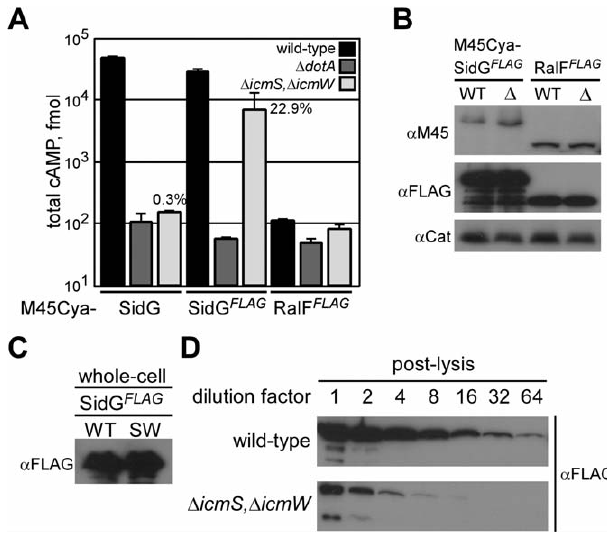
Figure 8. A C-Terminal FLAG Epitope Alters the Requirement for icmSW in SidG Translocation (A) CHO Fc c RII cells were infected with wild-type (black), D dotA (dark grey), or D icmS , D icmW (light grey) strains expressing the indicated Cya hybrid proteins. Total cAMP production induced by translocation of the hybrid was determined as in (Figure 1). % values represent translocation efficiency as a measure of ( D icmS , D icmW ) / wild-type. (B) Immunoblots of whole-cell bacterial extracts expressing Cya-SidG FLAG or Cya-RalF FLAG proteins from wild-type (WT) or D icmS , D icmW ( D ) probed with monoclonal antibodies specific to the M45 or FLAG epitopes. Immunoblots for chloramphenicol acetyltransferase (Cat) are included as a load control. (C) Immunoblots of whole-cell bacterial extracts expressing SidG FLAG from wild-type (WT) or D icmS , D icmW (SW) probed with monoclonal antibody specific to the FLAG epitope. (D) SidG FLAG was expressed in wild-type or D icmS , D icmW L. pneumophila strains to stationary phase. Cultures were harvested, lysed in the absence of protease inhibitors, and clarified. Lysates were subjected to serial dilutions that were mixed with sample buffer and analyzed by SDS-PAGE and immunoblotting with monoclonal antisera specific for the FLAG epitope.